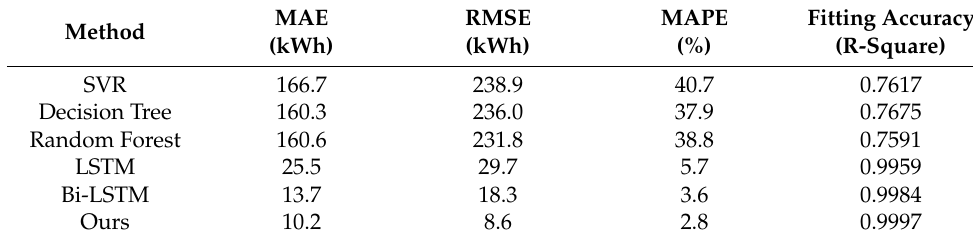
Table 7. Comparison of different